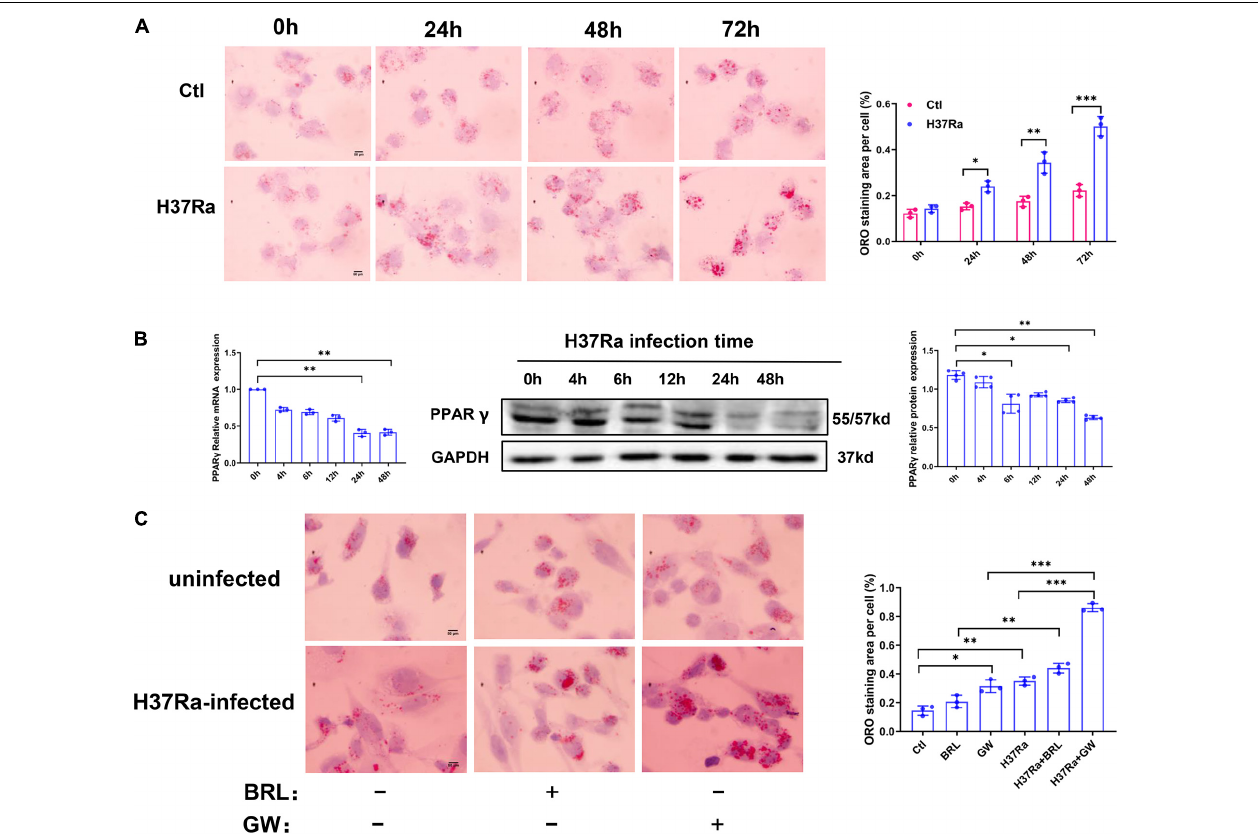
FIGURE 1 | Peroxisome proliferator activated receptor γ (PPAR γ ) is involved in Mycobacterium tuberculosis ( Mtb )-induced foamy macrophage (FM) formation. THP-1 cells were infected with (H37Ra group) or without (Ctl group) H37Ra (MOI = 10:1) and were cultivated for the indicated time points. Representative images of ORO-stained macrophages are presented [ (A) , left panel, 1,000 × ]. Intracellular lipid drops were quantified with ImageJ software [ (A) , right panel]. THP-1 cells were infected with H37Ra (MOI = 10:1) or 4 h, washed three times to remove extracellular Mtb and cultivated for different time points, then harvested for the detection of PPAR γ expression by RT–qPCR and western blot (B) . THP-1 cells were pretreated with a PPAR γ agonist BRL49653 (5 µ M) or antagonist GW966 2 (1 µ M) for 30 min, followed by infection with H37Ra for 72 h and staining with ORO [ (C) , 1,000 × ]. Scale bar = 50 µ m. Data are expressed as the means ± SD of at least